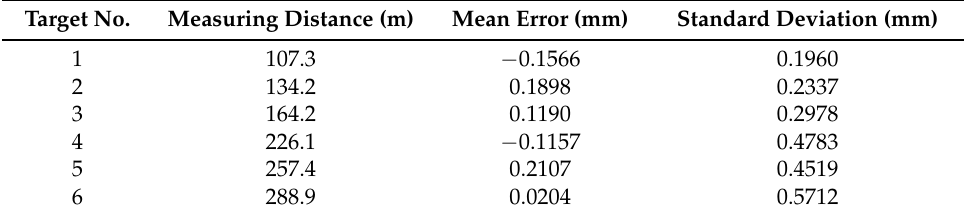
Table 2. Mean errors and standard deviation errors of the deflections measured for the six LED targets in the stationary condition.